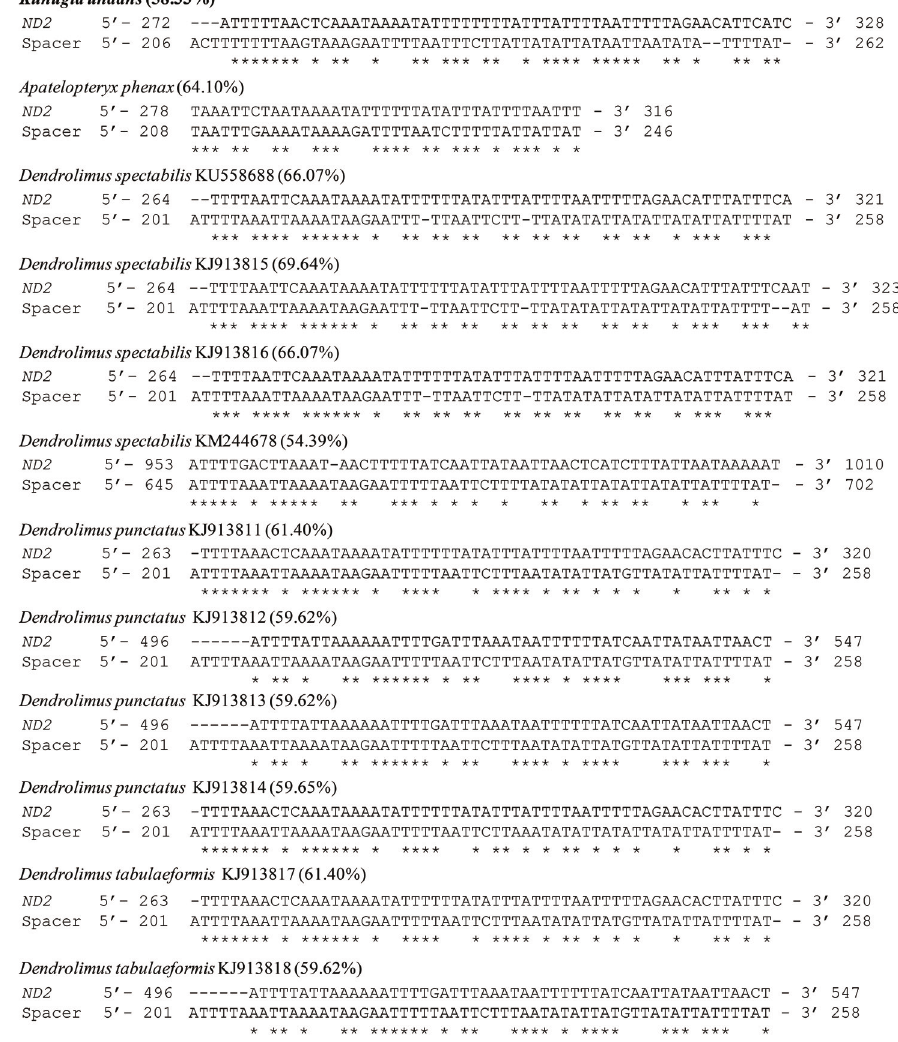
gmb-40-3.pdf 173gmb-40-3.pdf 173 8/28/2017 3:37:36 PM8/28/2017 3:37:36